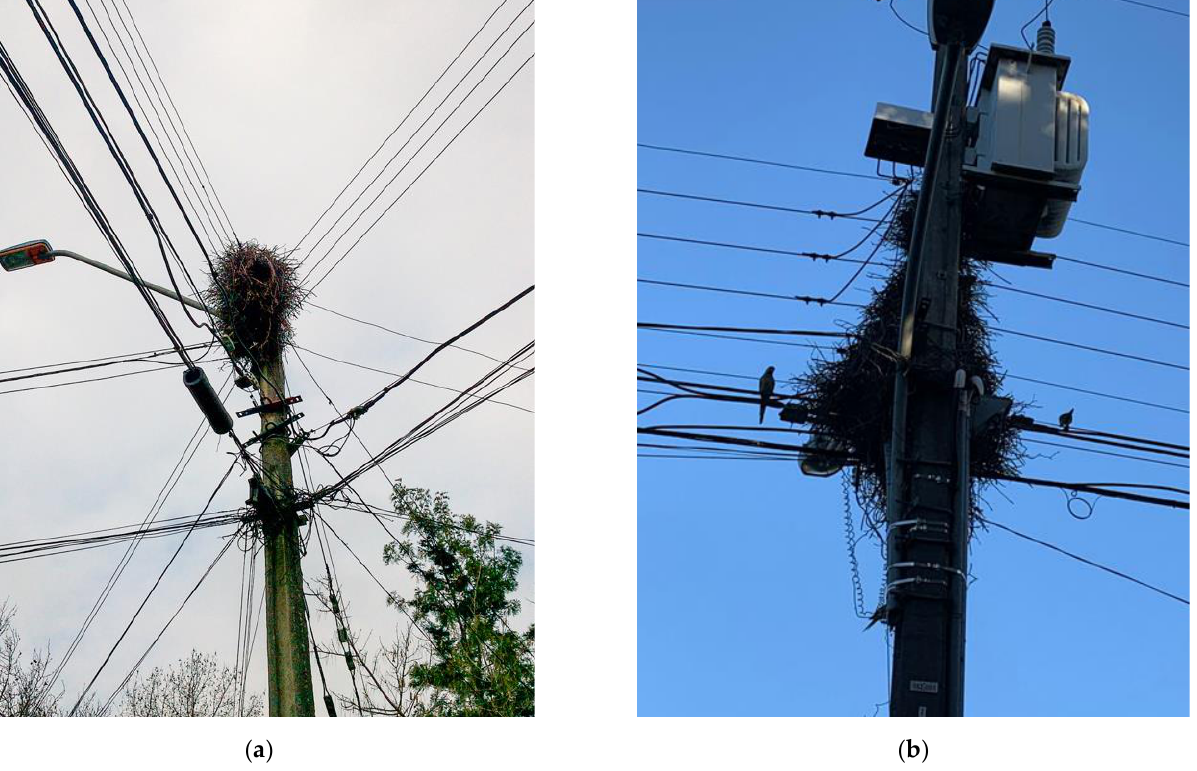
Figure 2. ( a ) The only Monk Parakeet nest found in a lamp post (9 m) in this study, conducted in Santiago metropolis, Chile between 2016 and 2019; ( b ) one of several Monk Parakeet nests constructed on utility poles (12 m) found in 2022 in Temuco City, some 600 km south to Santiago (J. E. Jiménez).